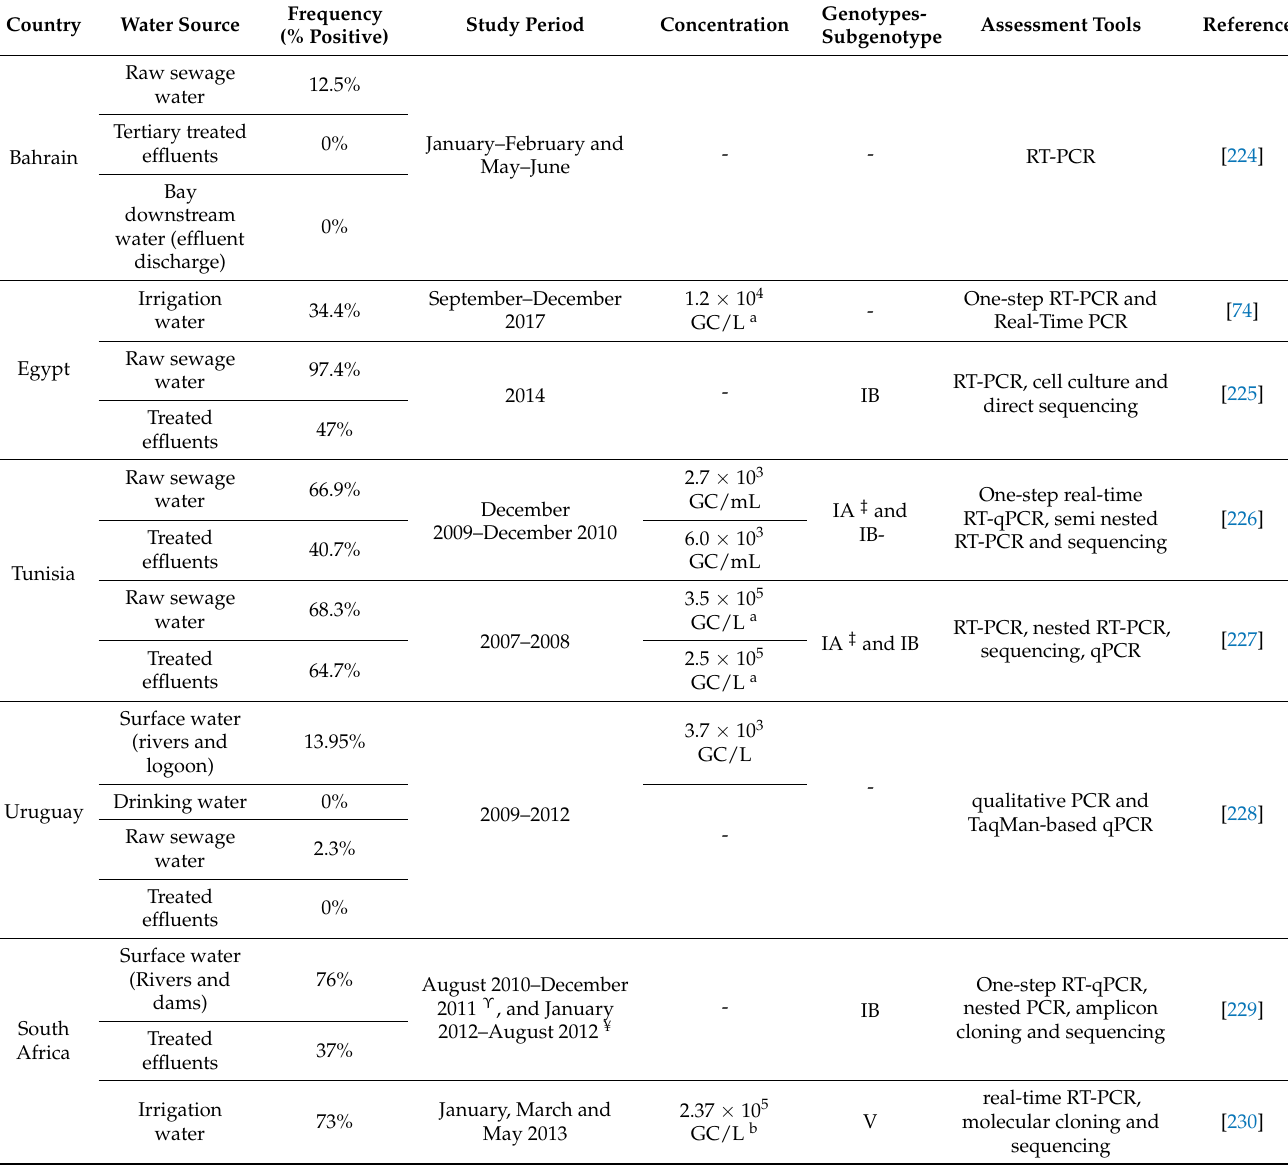
Table 4. HAV abundance in water environments and prevalent